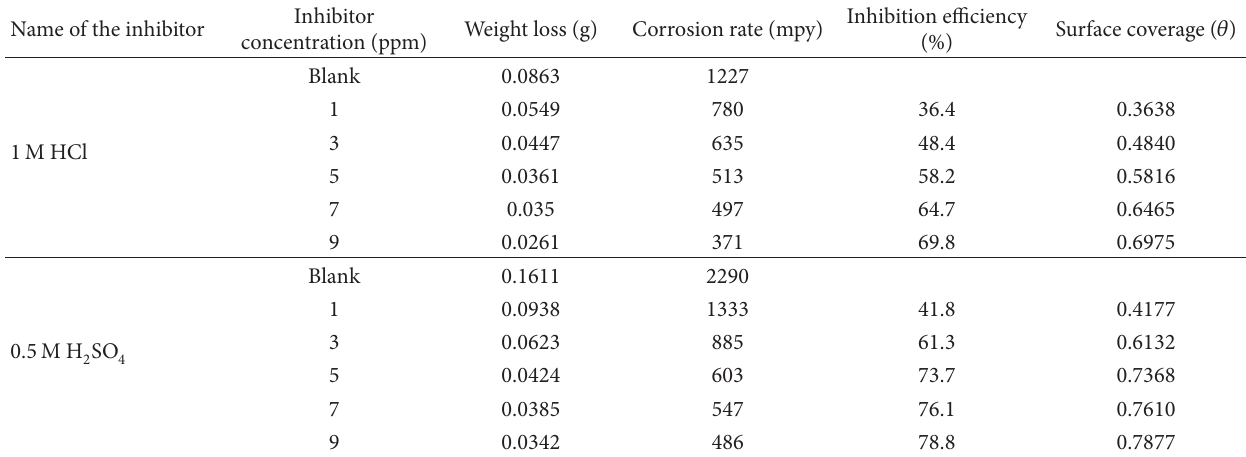
-phenyl-2 ,4 -dihydrospiro[indole-3,3 � � �